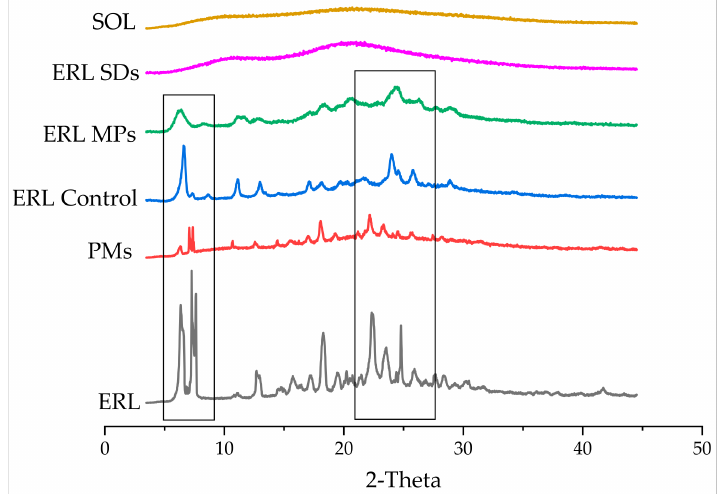
Figure 4. PXRD patterns of ERL, PMs, ERL control, ERL MPs, ERL SDs and